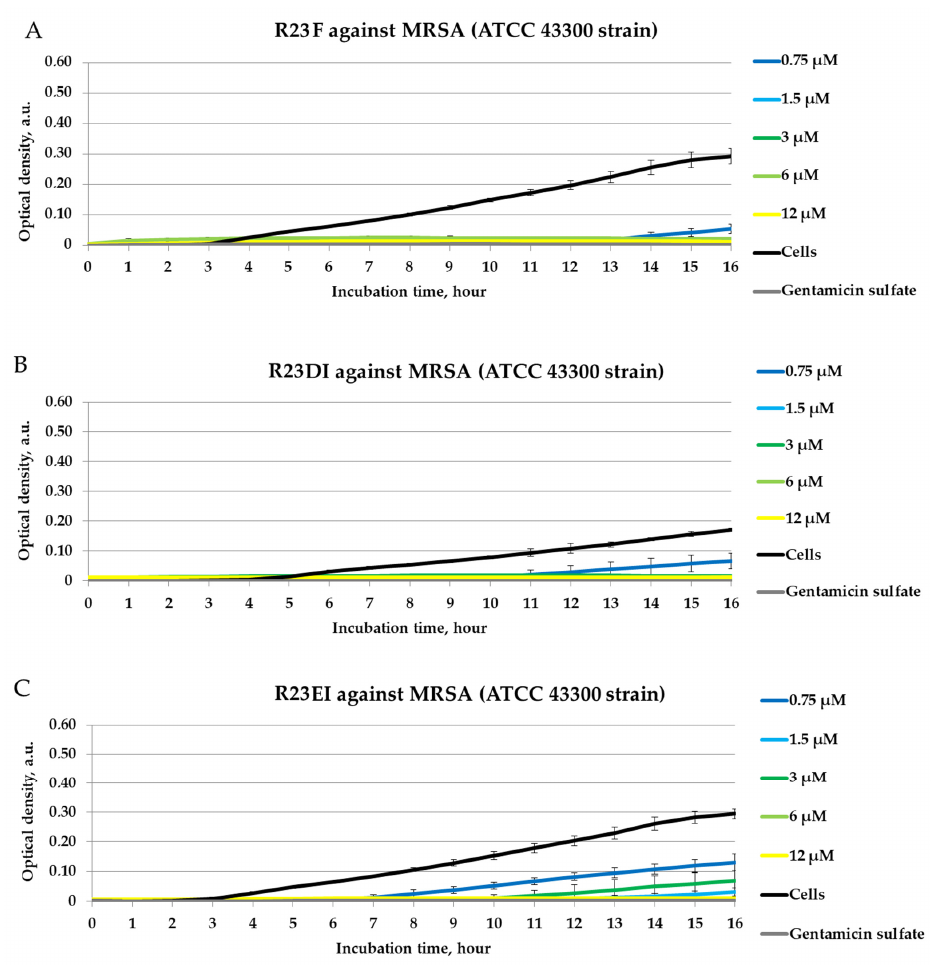
Figure 5. Inhibitory activity of peptides R23F ( A ), R23DI ( B ), R23EI ( C ) during 16 h of incubation with MRSA strain ATCC 43300 cells. A gentamicin sulfate concentration of 1700 μ M was used as a positive control of the antimicrobial effect. ATCC 43300 cells without peptide were used as negative controls. The experiments were performed in three replicates. The results were expressed as the mean ± standard deviation (M ± SD). Inhibition of MRSA growth for 24 h co-incubation with peptides R23F (1.5–12 μ M, MIC was 6 μ M), R23DI (1.5–12 μ M, MIC was 6 μ M), and R23EI (6–12 μ M, MIC was 12 μ M) was found. It should be noted that the peptides, by inhibiting the growth of MRSA cells, may have a temporary antibacterial effect, which tends to decrease over time. The antimicrobial action of the peptides was also assessed against cells of the S. au- reus 209P strain and P. aeruginosa ATCC 28753 strain (Figures 6 and 7).